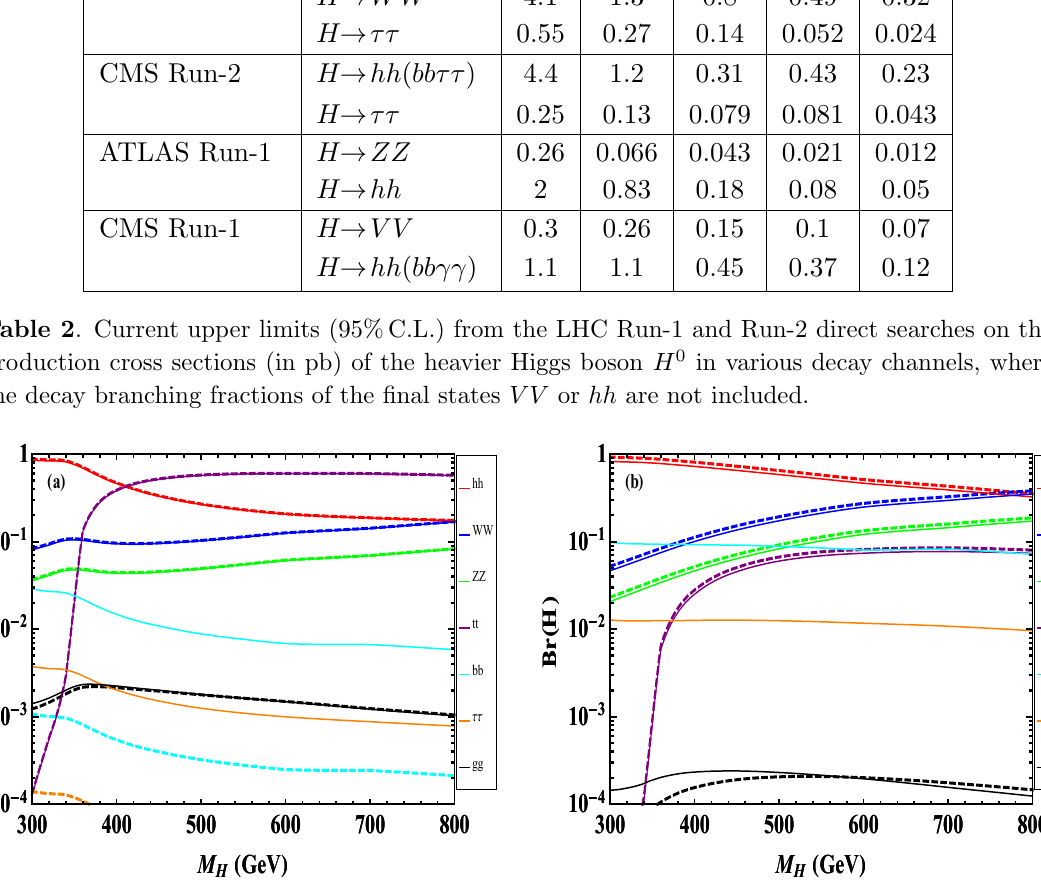
for H ; M 2 ) = (800GeV ; (cid:0) (200GeV) 2 ) 12 A